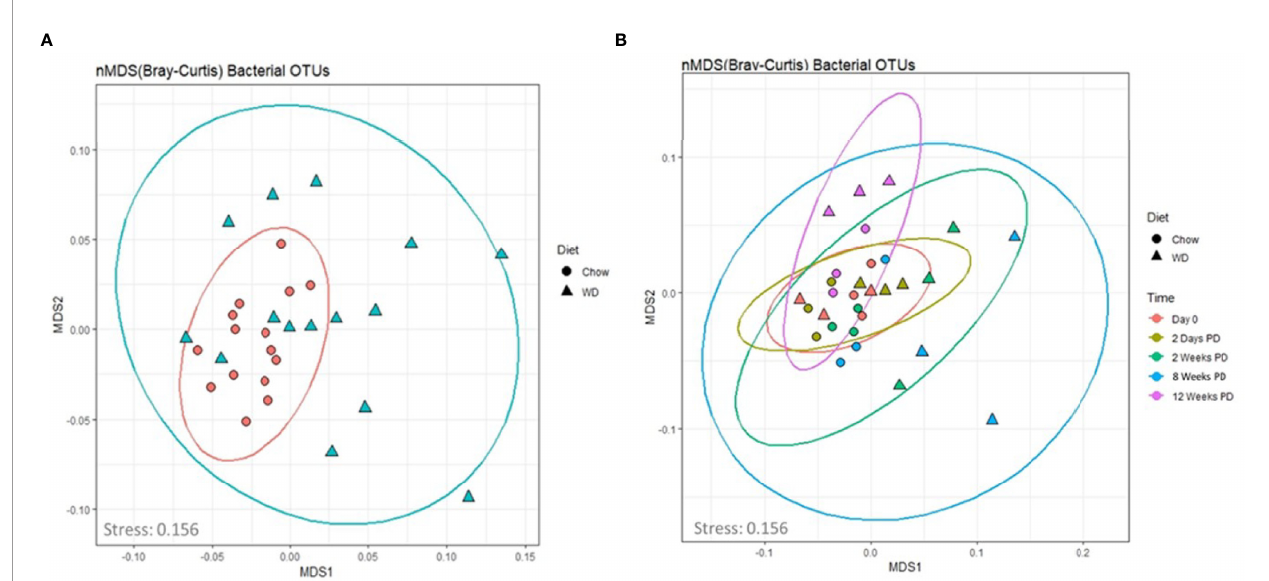
FIGURE 4 | An nMDS ordination of the microbiota samples (A) by diet and (B) over time. The taxonomic pro fi les of the samples were used to compute the sample dissimilarity matrix using Bray-Curtis dissimilarity index. The matrix was used to compute an ordination of the samples in two dimensions (MDS1 and MDS2). The stress associated with this ordination is 0.156. The shapes in plot B denote the diet (Chow and WD), where the color denotes the time point (0 days, 2 days and 2, 8 and 12 weeks on the